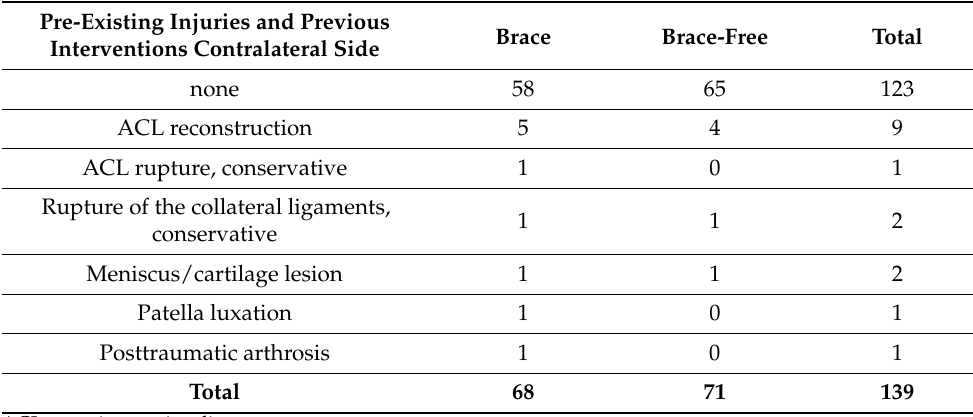
ACL, anterior cruciate